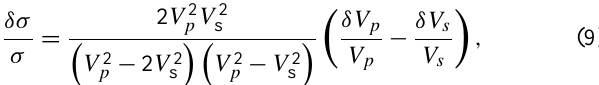
Figure 6. Panels a and b show examples of travel-time sensitiv- ity kernels for the starting model m 1 of (a) the first arrival of P waves and (b) the first arrival of S waves. The earthquake is the same one as in Fig. 5 but the seismic station is at an epicentral dis- tance of 87 . 24km. In this case, the first arrivals are seismic waves refracted from the 5 . 5km discontinuity but overlapped by other later phases. The dashed grey lines denote the velocity discontinu- ities at the depth 2.0km and 5.5km, and the Conrad discontinuity (16 . 0km). Panels c and d show the corresponding synthetic P wave and S wave seismograms (black curves). The purple lines indicate the arrival times of the head waves refracted from the discontinu- ity at the depth of 5.5km, the blue lines denote the onset times of the direct waves ( Pg and Sg ), the pink lines show the arrival times of the head waves refracted by the Conrad discontinuity, and the brown lines denote the arrival times of the reflected phases from the 5.5km discontinuity ( Pr and Sr ). The red waveforms are the win- dowed and tapered seismograms used to compute the travel-time sensitivity kernels of the first arrivals shown in ( a and b